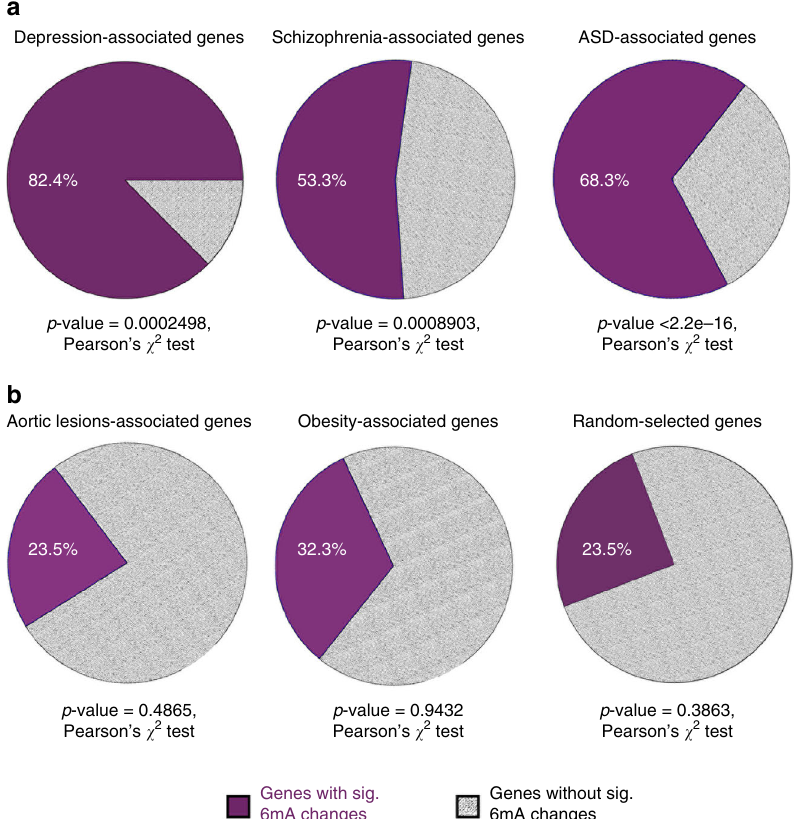
Fig. 5 Dynamic 6mA is associated with depression-linked genetic loci. a Signi fi cant overlap between depression-associated genes containing the top 17 most signi fi cant SNPs, schizophrenia (SCZ)-related risk genes and autism spectrum disorders (ASD)-related risk genes with dynamic 6mA marked genes upon stress are indicated. P -value was calculated by Pearson ’ s χ 2 test. b The genes related to aortic lesions, obesity or randomly selected genes did not show signi fi cant enrichment. Statistical signi fi cance was calculated by Pearson ’ s χ 2 tests, and p -values are